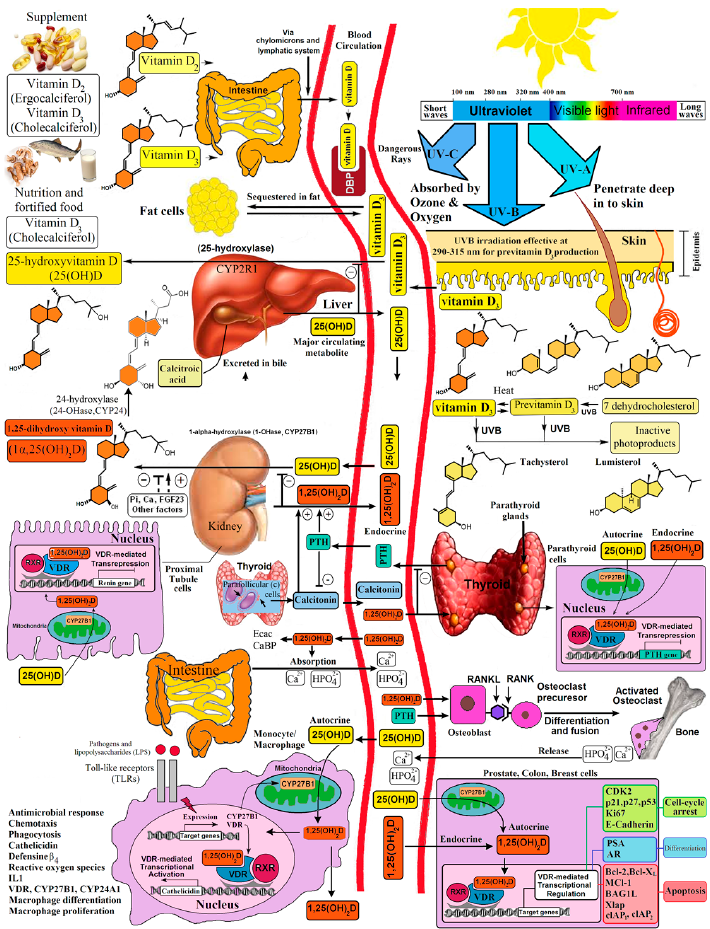
Figure 7. Schematic representation of the synthesis and metabolism of vitamin D for skeletal and extra-skeletal function. During exposure to sunlight, 7-dehydrocholesterol in the skin is converted to previtamin D 3 . Previtamin D 3 immediately converts by a heat-dependent process to vitamin D 3 . Excessive exposure to sunlight degrades previtamin D 3 and vitamin D 3 into inactive photoproducts. Vitamin D 2 and vitamin D 3 from dietary sources are incorporated into chylomicrons and are trans- ported by the lymphatic system into the venous circulation. Vitamin D (D represents D 2 or D 3 ) made in the skin or ingested in the diet can be stored in and then released from fat cells. Vitamin D in the